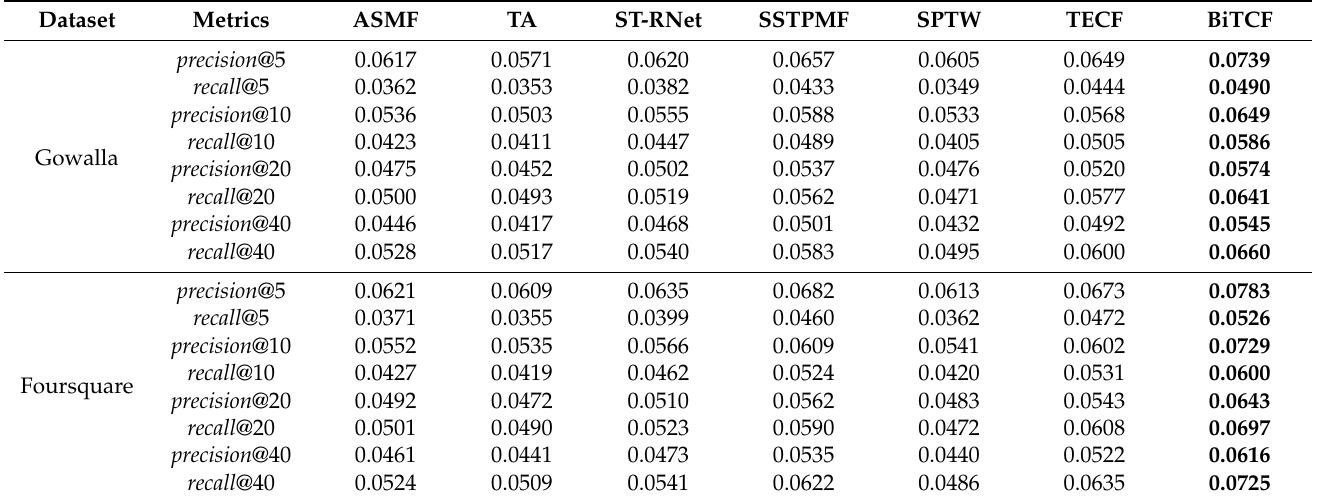
Table 4. Comparisons on the performance of the models with top- k POIs in dimension K =20.